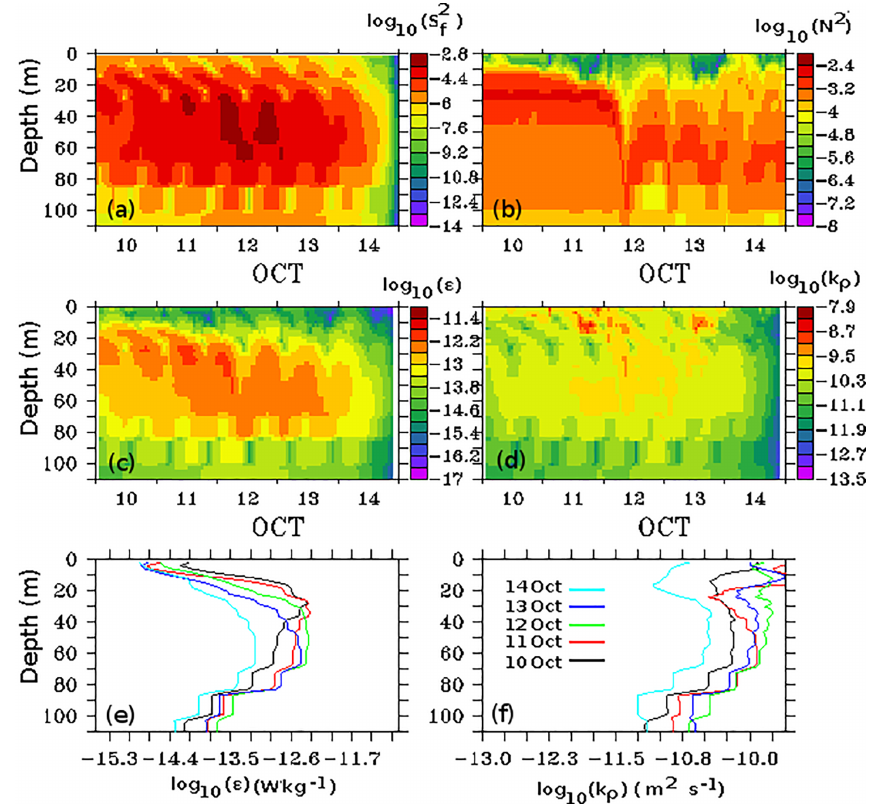
Figure 12. Profiles of (a) velocity shear log 10 (S 2 ) , (b) buoyancy frequency log 10 (N 2 ) , (c) turbulent kinetic energy dissipation rate log 10 ( ε ), and (d) turbulent eddy diffusivity log 10 ( K ρ ) ; (e) and (f) are daily averaged turbulent kinetic energy dissipation rate and turbulent eddy diffusivity,